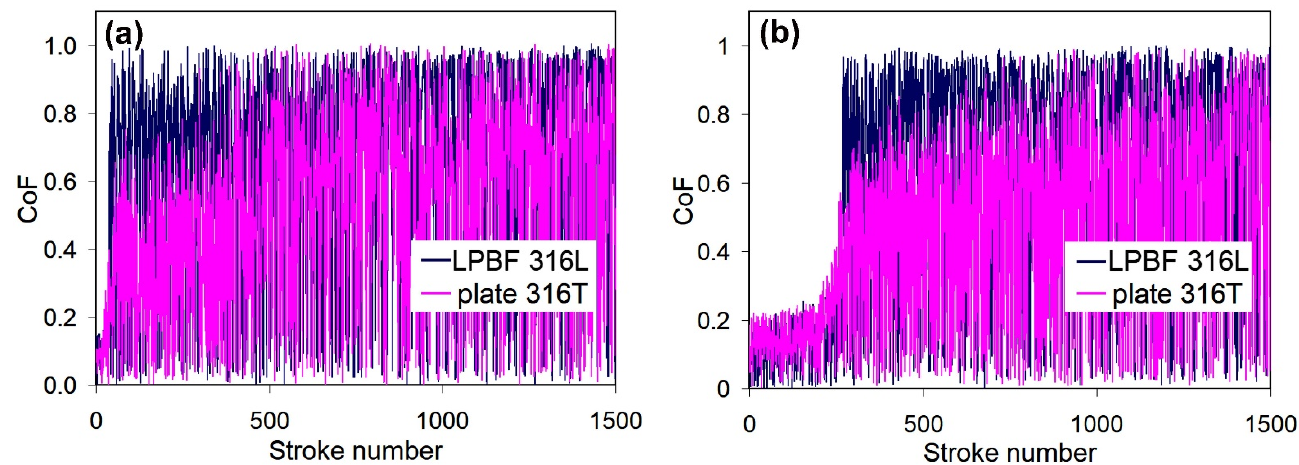
Figure 12. Variations of CoF for the specimens during dry sliding wear: ( a ) as-received and ( b ) plasma-treated stainless steels.